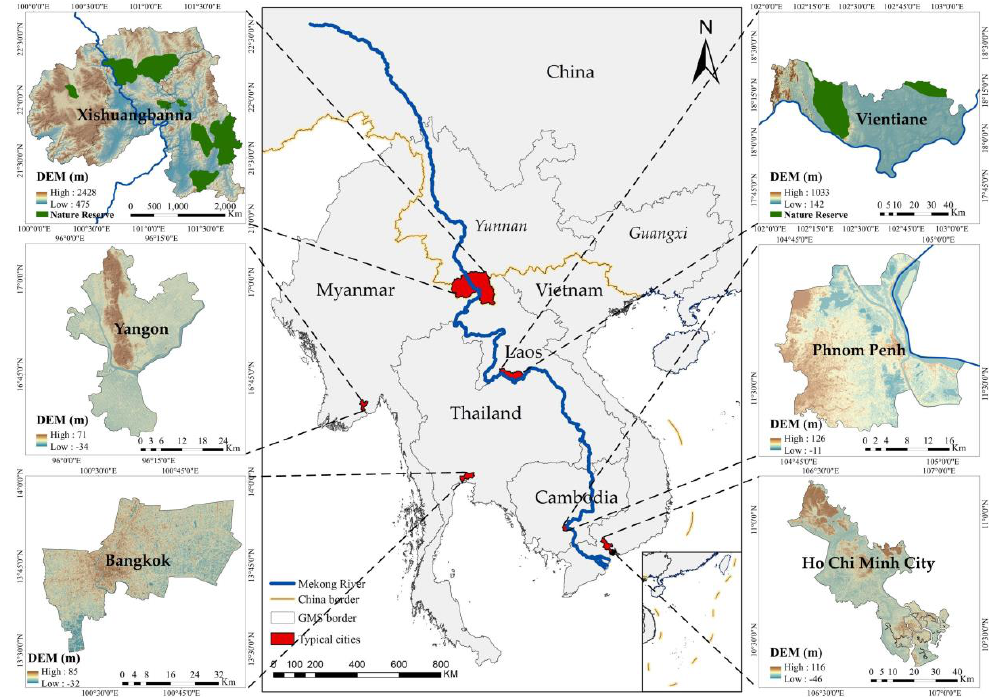
Figure 1. Locations of six typical cities in the Greater Mekong Subregion (GMS).